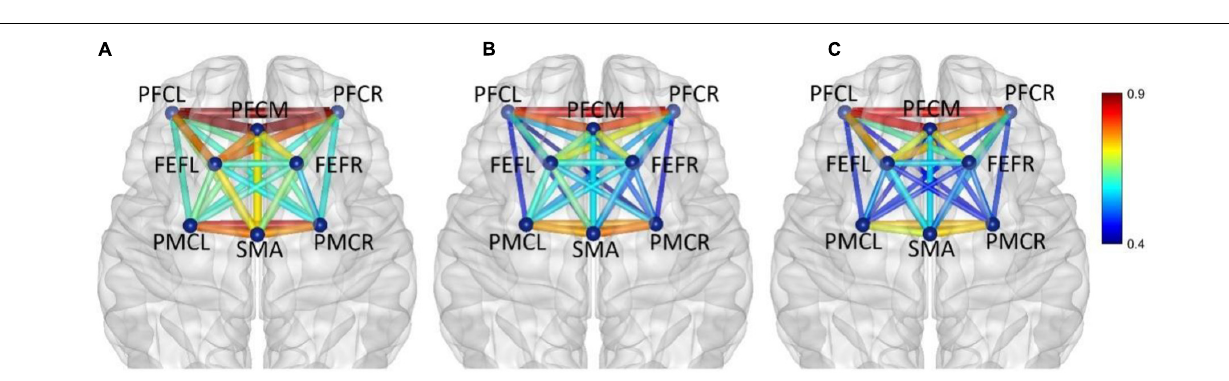
FIGURE 7 | In frequency band III (0.052–0.145 Hz), non-fatigue (A,B) moderate fatigue, (C) severe fatigue. The average cortical functional connectivity network contains 8 ROI brain regions. The width and color of the line represent the strength of the